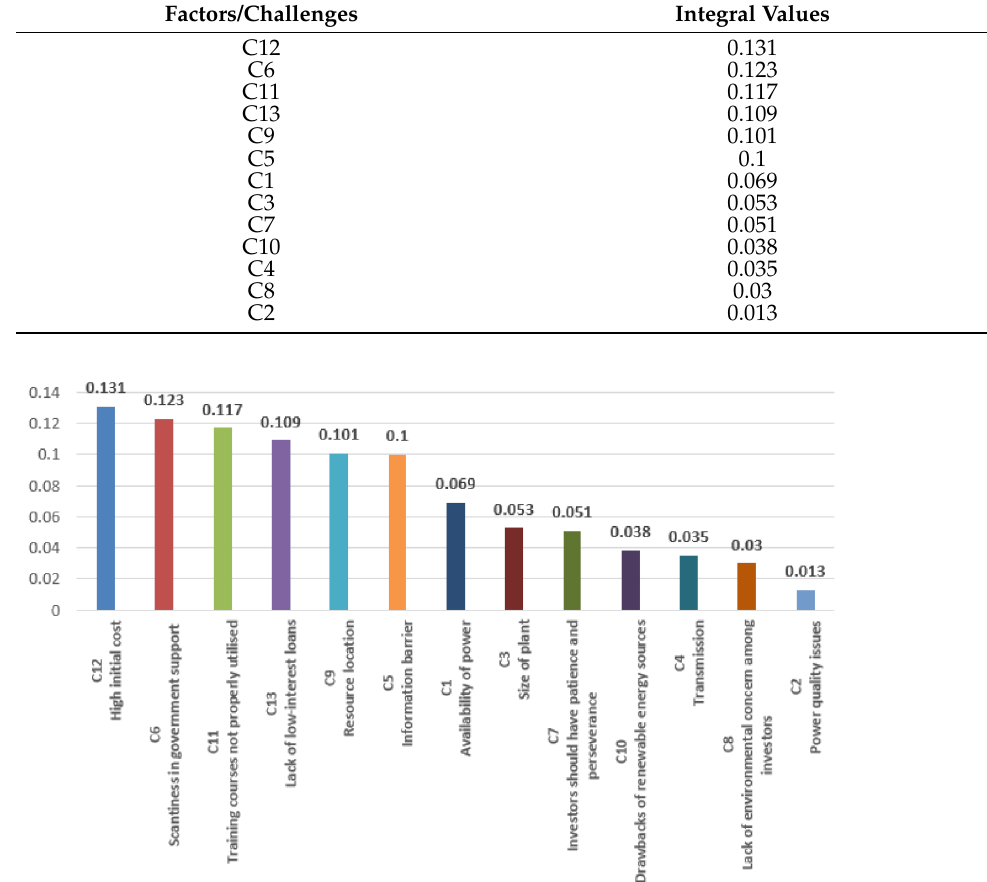
Figure 4. Ranking of the challenges by integral